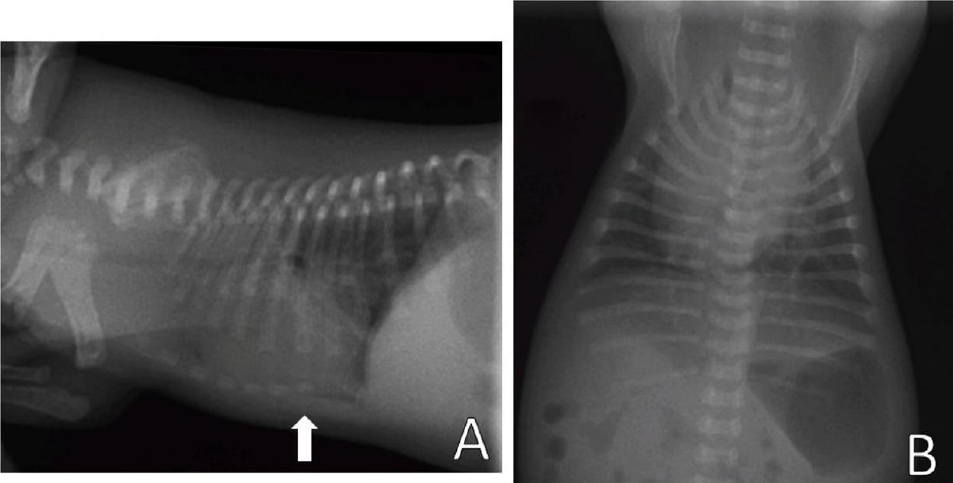
Figure 11. Chest X-ray. ( A ) Right lateral position, demonstrating ventrodorsal deviation of the sternum bone (arrow). ( B ) Ventrodorsal position, demonstrating rounded cardiac silhouette and right cardiac deviation.